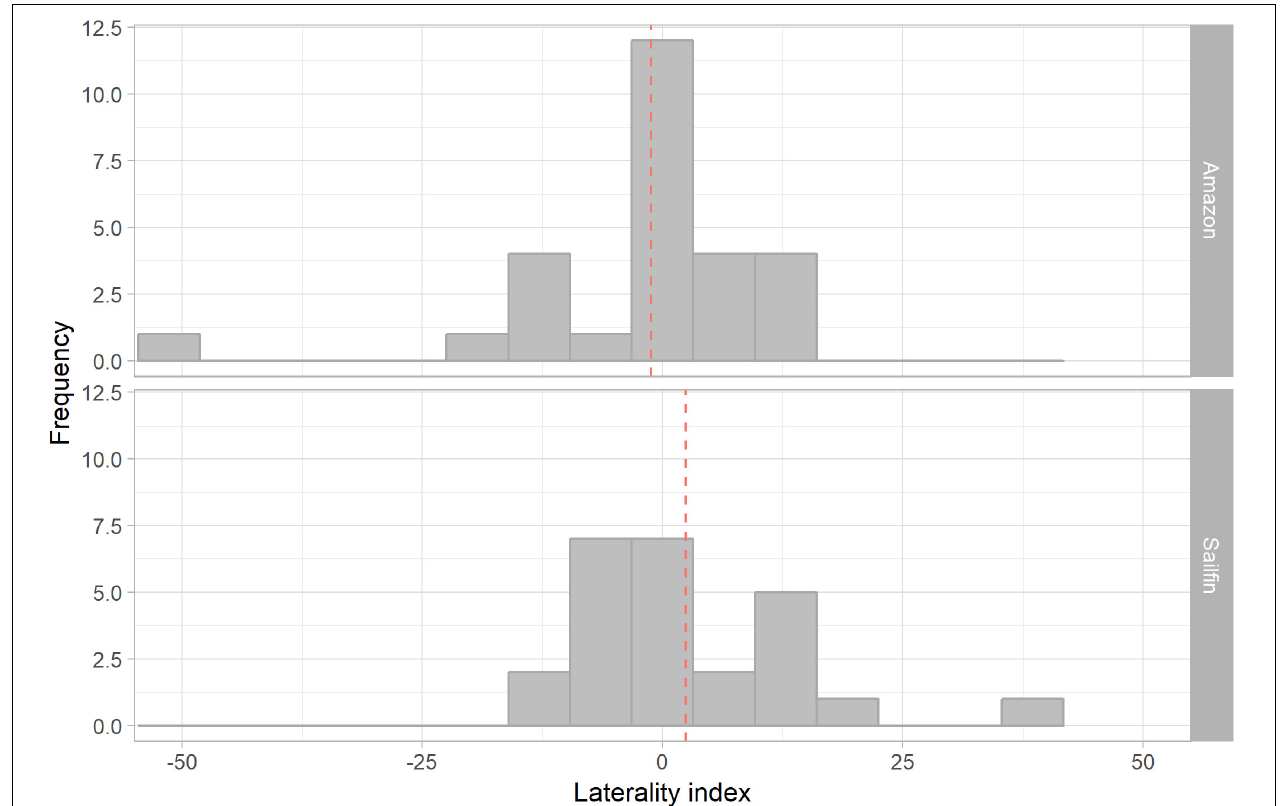
FIGURE 3 | Frequency of laterality index scores among Amazon and sailfin mollies. The red dashed line represents the group mean. Variation in laterality index scores was not clearly different between Amazon and sailfin mollies.